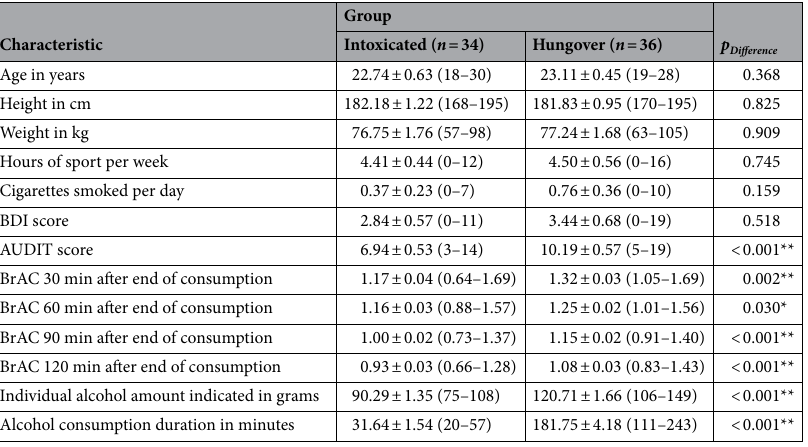
Table 1. Comparison of sociodemographic characteristics, questionnaire scores and alcohol-related data between both groups. All values are reported as means ± standard error of the mean and the range is given in parentheses. The comparisons were performed with uncorrected independent t-tests or Mann–Whitney U-tests (in case of non-normal distributions). Both groups differed in their AUDIT score, which most likely resulted from the application of different AUDIT inclusion criteria during recruiting. Both groups also differed in their alcohol-related data as the experimental protocols systematically differed between the two groups (e.g., alcohol amount, consumption duration, type of alcohol, abstaining from meals before the appointment). BDI Beck depression inventory; AUDIT alcohol use disorders identification test; BrAC breath alcohol concentration; * p < .05, ** p <